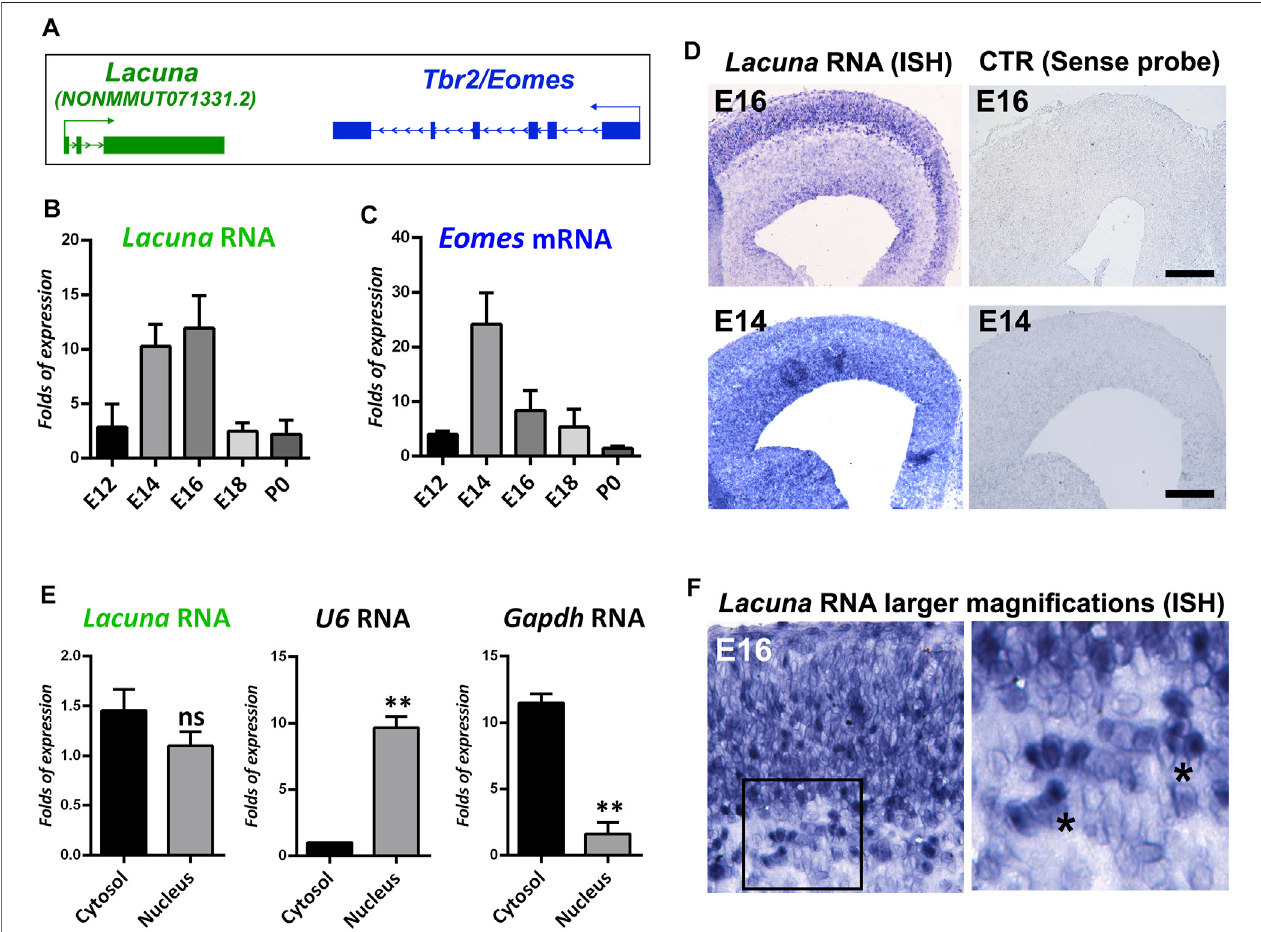
FIGURE 1 | Lacuna is expressed in the mouse brain during embryonic development. (A) Schematic representation of Lacuna and Tbr2/Eomes locus. (B) RNA levelsof Lacuna duringmouseembryonicbraindevelopment. (C) mRNAlevelsofEomesduringmouseembryonicbraindevelopment. (D) Insitu hybridizationof Lacuna incryosectionsfromE16 andE14 mouseembryonic brainwiththecorrespondingcontrols,asindicated. (E) Subcellularfractionation ofNSCs and RNAlevels of Lacuna in each subcellular compartment. mRNA levels of U6 and Gapdh were used to verify the fractionation of cells (** p < 0.01, n (cid:2) 3). (F) Higher magni fi cation micrographs of the In situ hybridization experiment with Lacuna speci fi c riboprobe in E16 mouse embryonic brain (left panel) . Image in the right panel depicts larger magni fi cation(40x)oftheareaincludedinthesquareshapeoftheimageintheleftpanel(20x).Asterisksindicaterepresentativecellswherethe Lacuna islocalizedbothin cytosol and